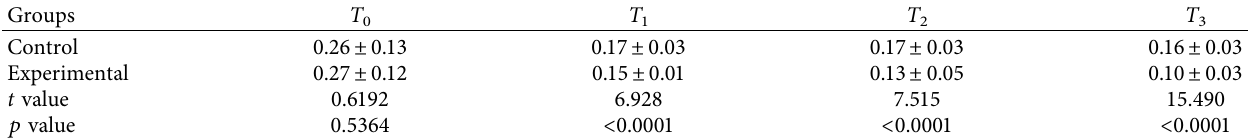
Table 2: The horizontal comparison of S100- β between two groups at different time points ( x ± S , μ g/L).